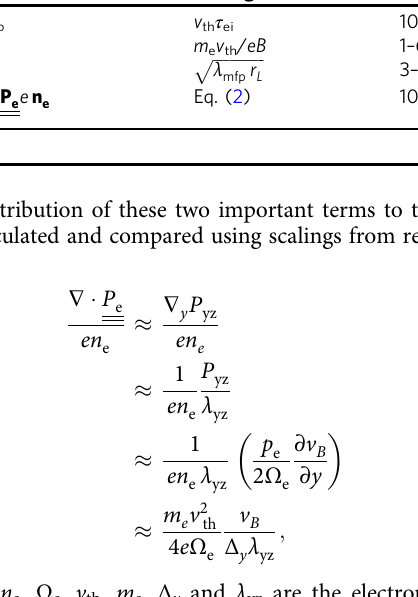
Table 1 Contributions to Ohm ’ s law.